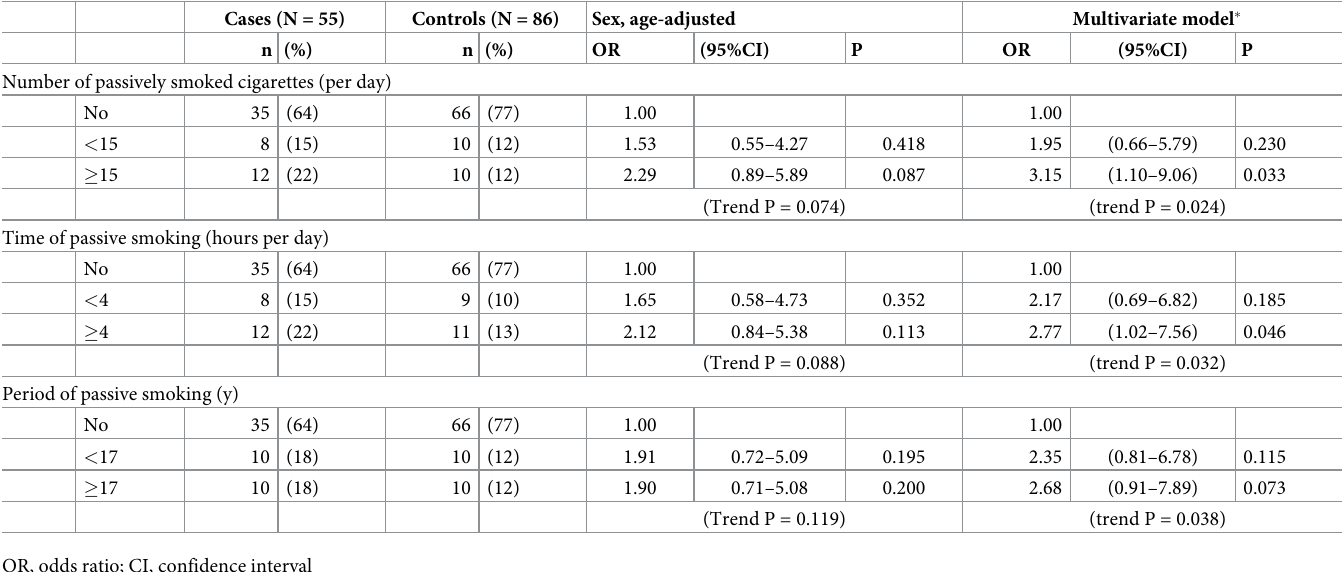
Table 4. Association between passive smoking and the development of Crohn’s